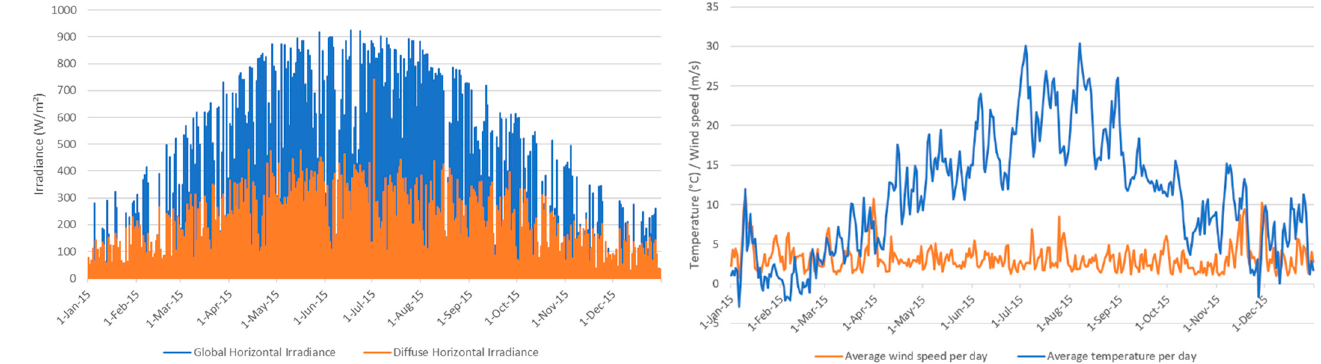
Figure 1. Global and diffuse irradiance ( left ), and temperature and wind speed data (daily averaged values) ( right ), used as input for the simulation (data source: [6]).